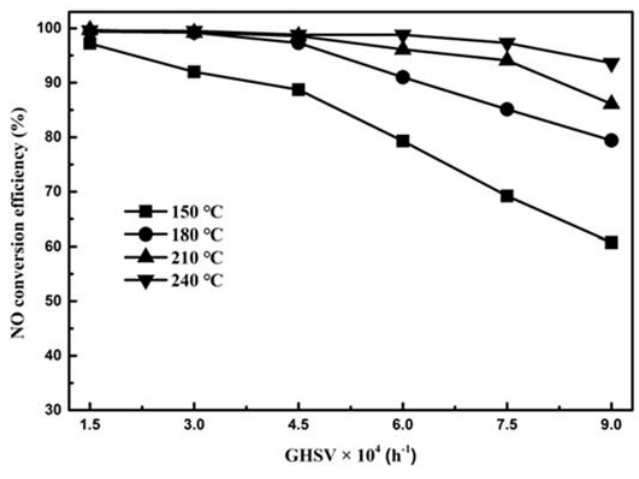
Figure 6. Effect of reaction temperature and GHSV on denitrification efficiency of NG-Mn10Ce41 catalyst.